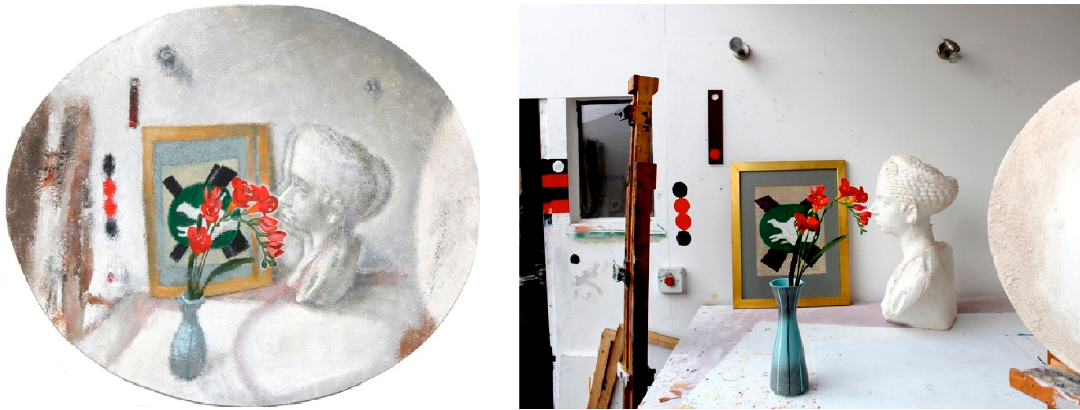
Figure 3. ( Left ) Still life with objects, Robert Pepperell, oil and sand on shaped canvas, 2012. ( Right ) Linear perspective photograph of same physical space depicted in the painting showing approximately the same visual space but taken from a point of view further back than that from which it was painted. Note the relative enlargement of the centrally located objects, the diminution of objects in the periphery of the painting compared to the photograph, as well as the binocular doubling in the area behind the flowers and the fall of in acuity with eccentricity.